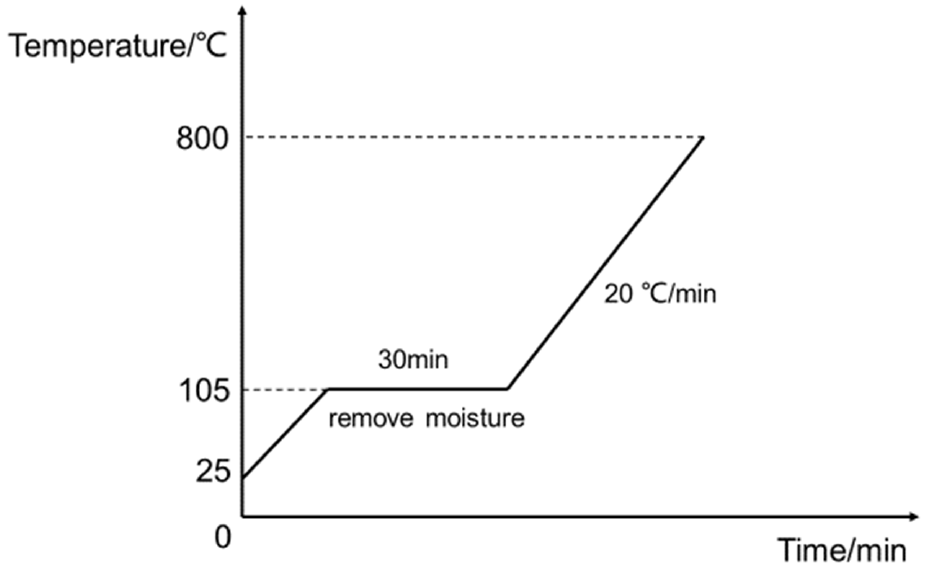
Figure 3. Schematic diagram of temperature rise for TGA/DTG test.